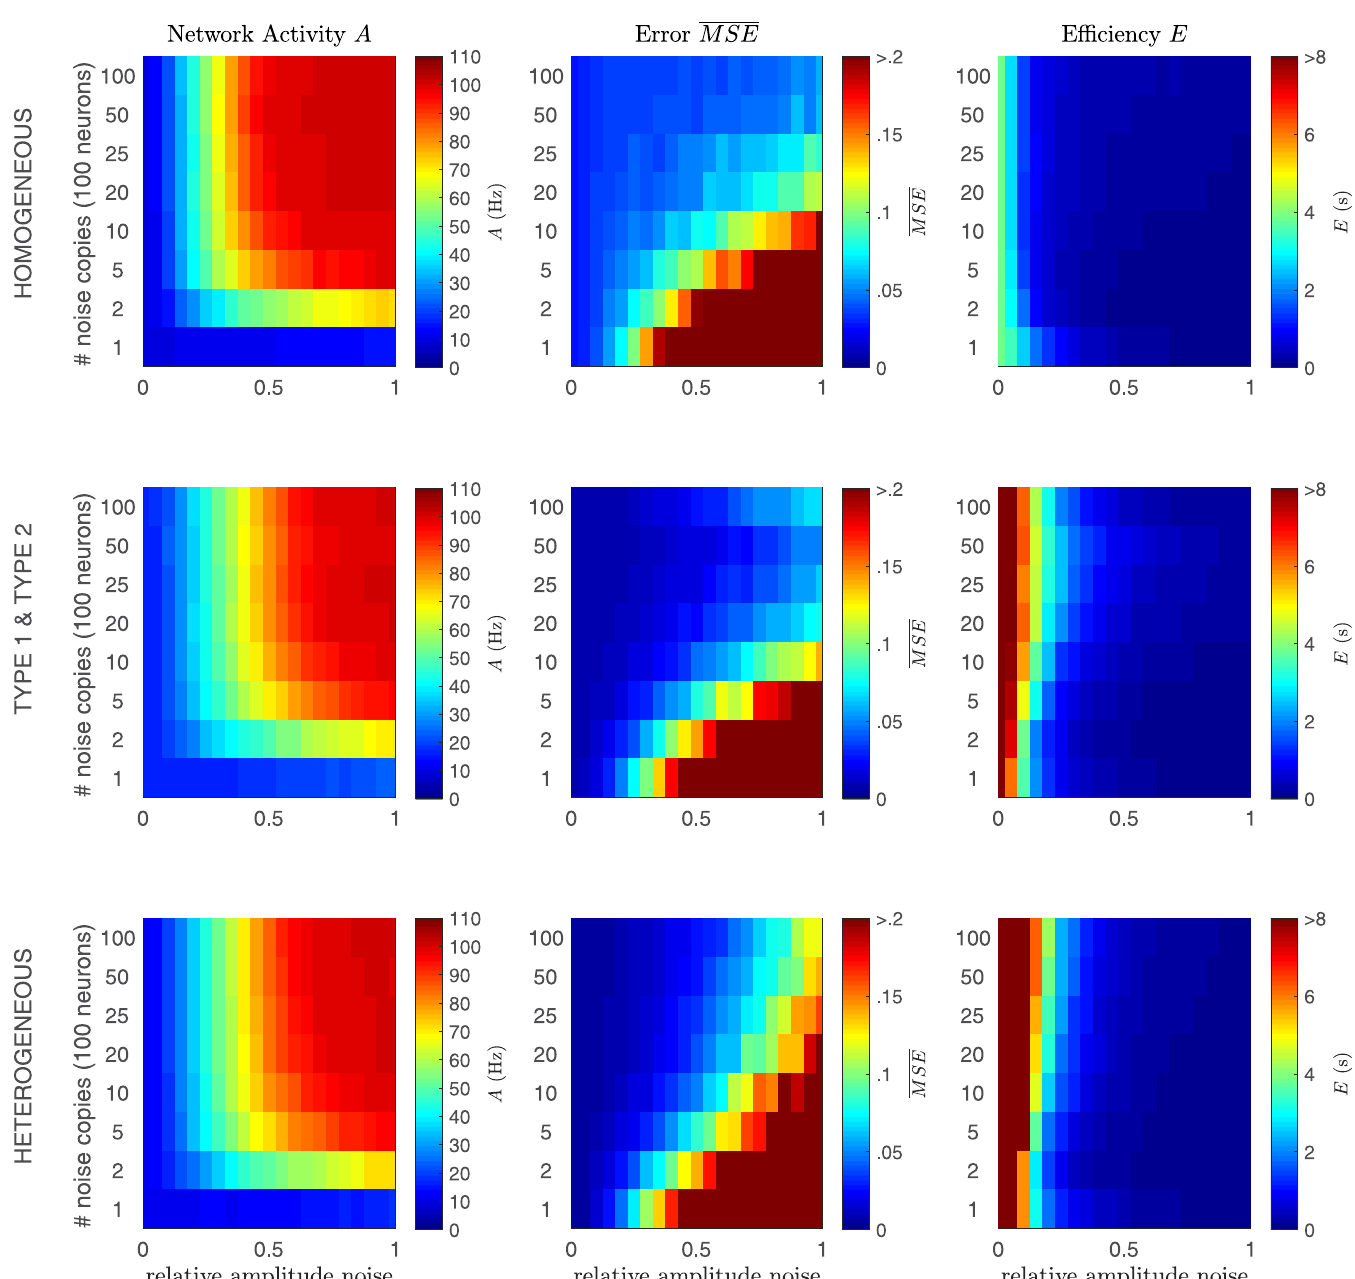
Fig 5. Heterogeneous networks are more robust against noise. Network activity A (first column), network error � MSE (second column) and efficiency E (third column) of a homogeneous network (top row), a network with ‘type 1’ and ‘type 2’ neurons (middle row) and a heterogeneous network (bottom row). Next to the stimulus, each neuron in the network was presented with a noise input, with a varying relative amplitude (horizontal axis) and number of copies of the noise signal (vertical axis; 1 copy means all neurons receive the same noise, 100 copies means all neurons receive independent noise). Network: Δ = 7, 5 ms, ν = μ = 1, 5, N = 100. Stimulus: amplitude = 10, τ = 15 ms. Noise: τ = 15